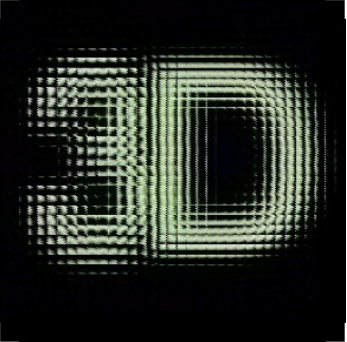
Figure 9. Elemental image array for reconstruction 3D image.